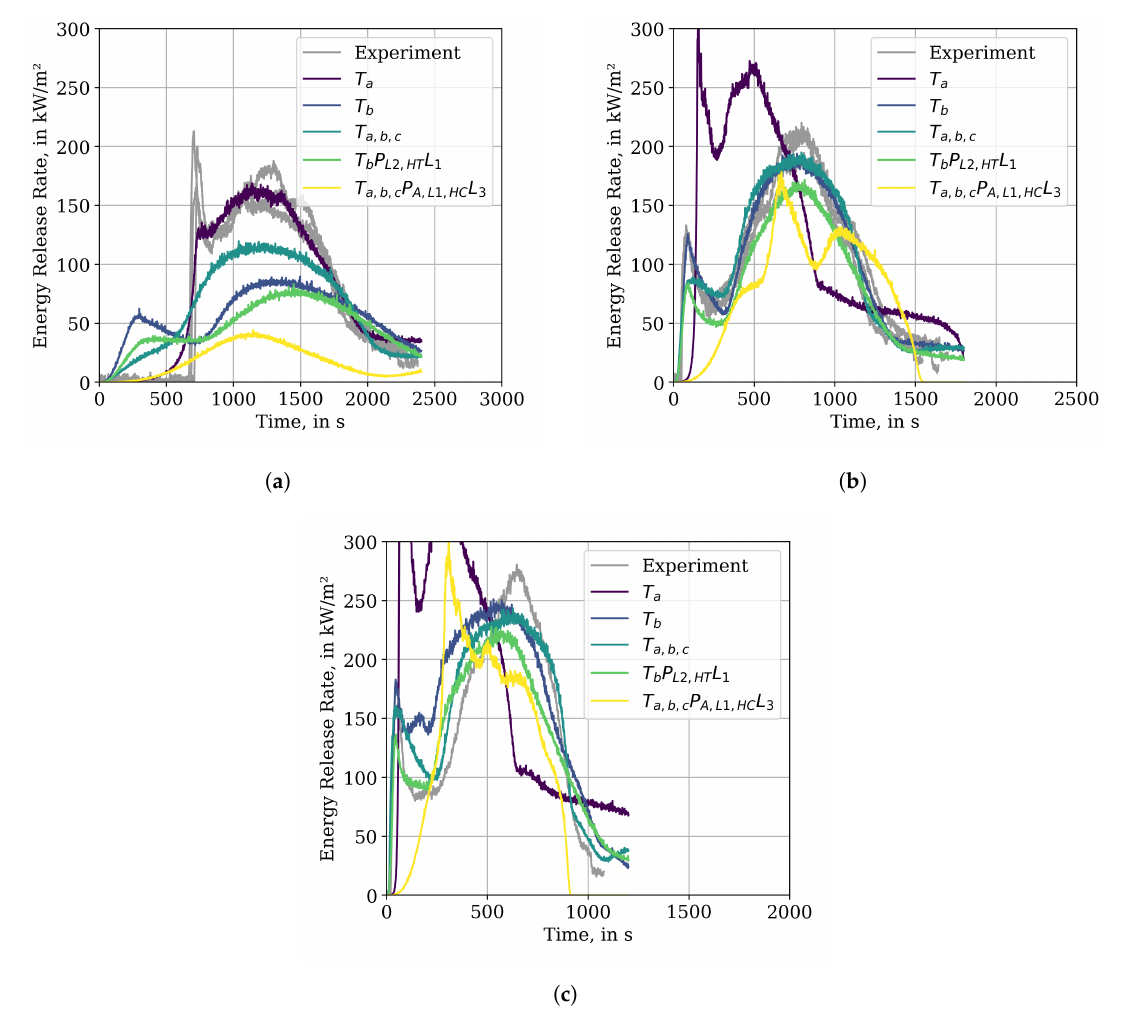
Figure 6. Comparison between energy release rates of Cone Calorimeter simulation, across global best parameter sets. ( a ) External heat flux of 25 kW / m 2 . ( b ) External heat flux of 50 kW / m 2 . ( c ) External heat flux of 75 kW / m 2 .